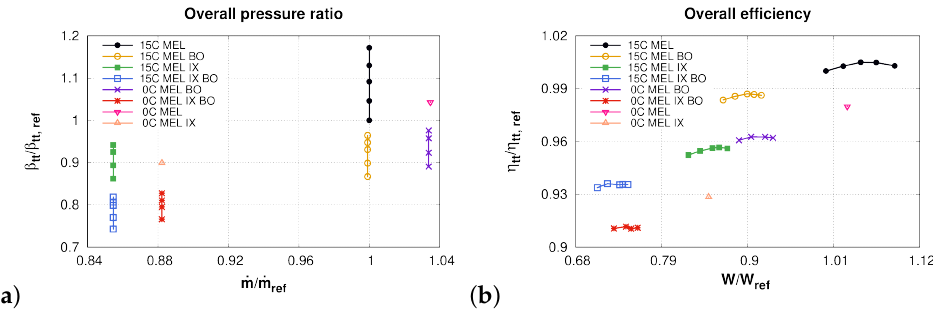
Figure 9. Test matrix overall pressure ratio ( a ) and polytropic efficiency ( b ) for the six configura- tions